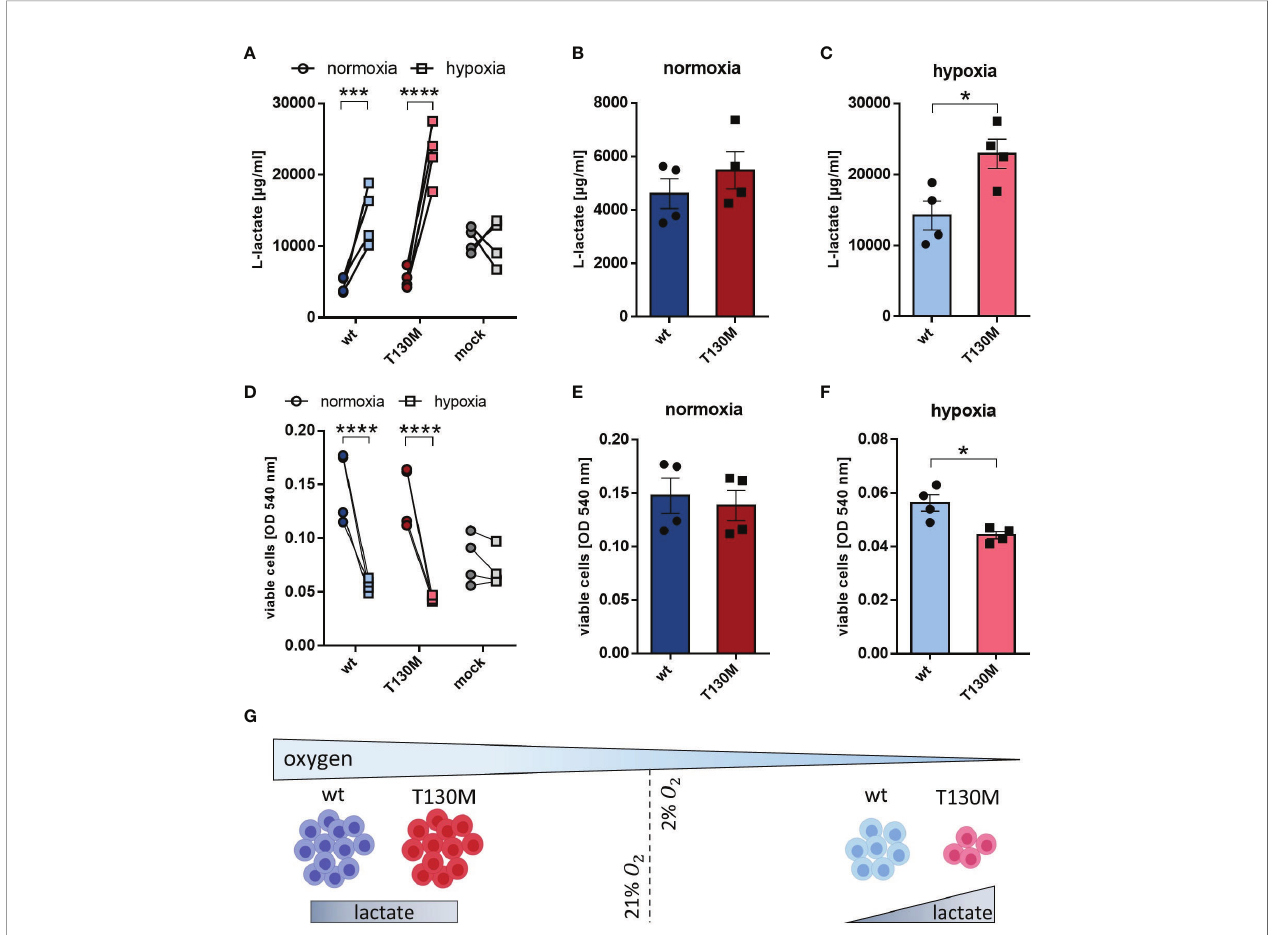
FIGURE 5 | P32-T130M increases glycolysis and decreases proliferation of HAP1 cells under hypoxia. (A – C) HAP1 transfectants were cultivated under (B) normoxic or (C) hypoxic conditions for 72 h. L -lactate production was measured in cell culture supernatant and normalized to the number of viable cells. (D – F) Cell viability of HAP1 transfectants being cultivated for 72 h under (E) normoxia or (F) hypoxia was determined by a neutral red assay. (G) Under hypoxic conditions glycolysis is increased and cell proliferation is decreased for HAP1-p32-T130M compared to HAP1-p32-wt cells. For (A , D) and (C , F) statistical signi fi cance was determined using a two-way ANOVA followed by Sidak ’ s multiple comparison test or an unpaired t-test, respectively. *p ≤ 0.05, ***p ≤ 0.001, ****p ≤